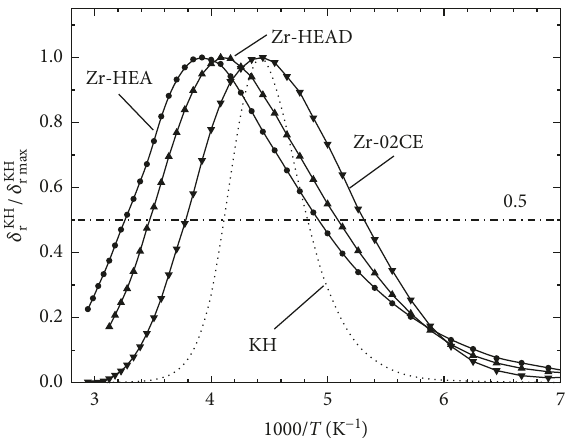
/ δ KH 1 /T r rmax ( )